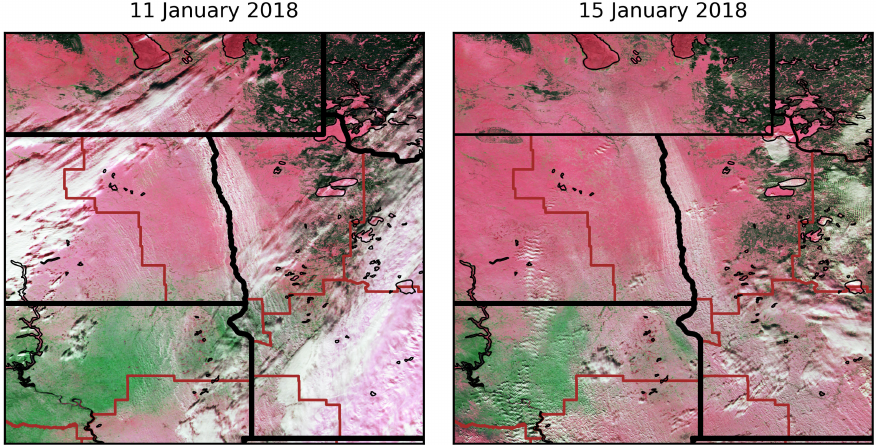
Figure 2. False color imagery (generated from I1-I2-I3-M3-M11 bands) from the Visible Infrared Imaging Radiometer Suite (VIIRS) onboard the Suomi satellite during the daylight (~1:30pm local time) overpass on ( a ) 11 January 2018 and ( b ) 15 January 2018. Snow cover is denoted by pink / red, cloud cover and blowing snow by white, and bare landscape by green (bare ground) or dark (forest) areas. Blowing snow plumes oriented along the RRV are labeled by